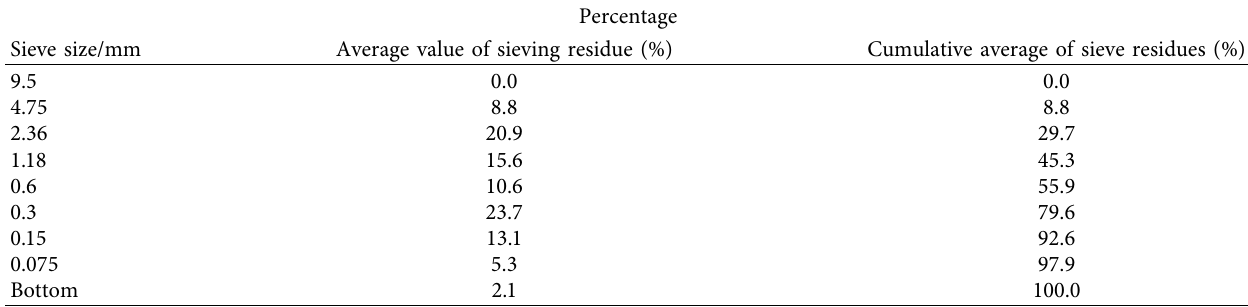
Table 2: Fine aggregate gradation of shotcrete.